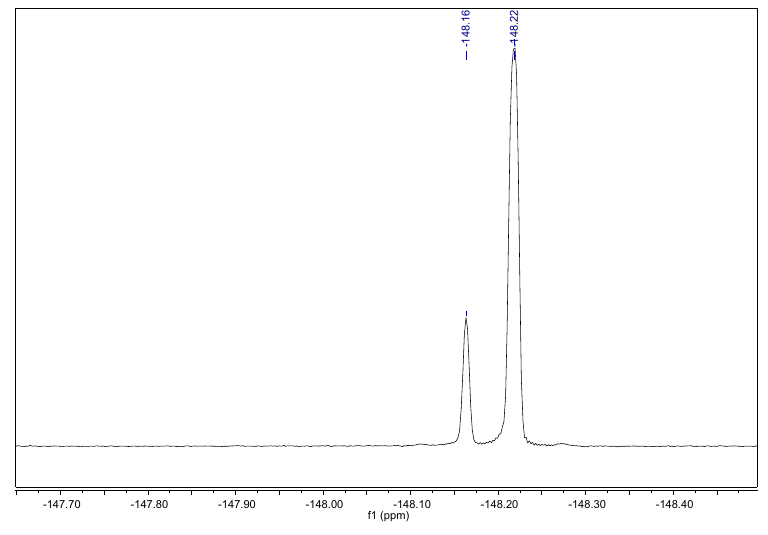
Figure 6. 19 F NMR spectrum of compound 25 .